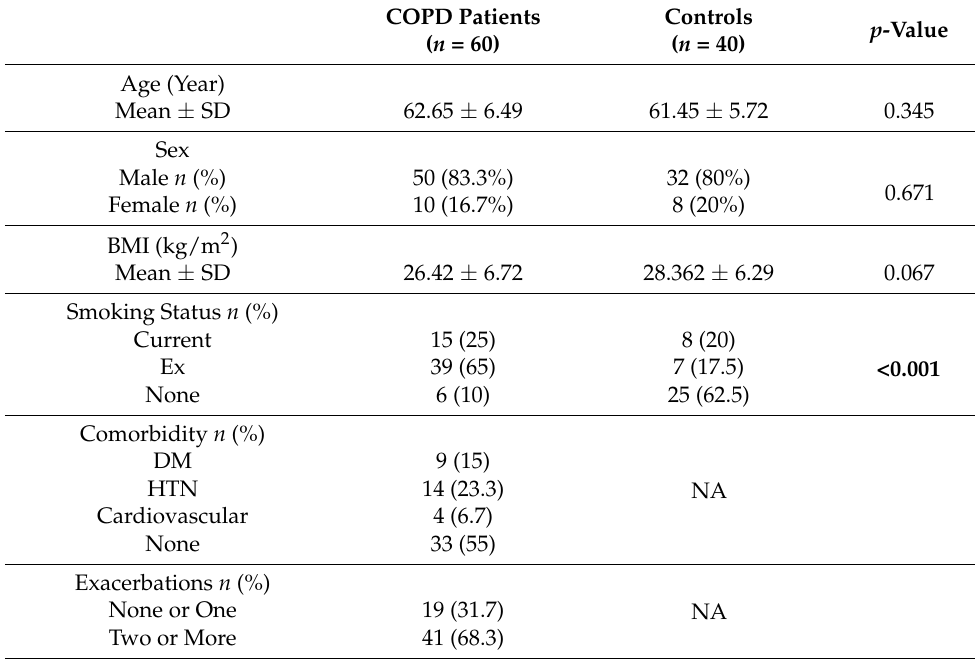
Table 1. Demographic and clinical characteristics of COPD patients and